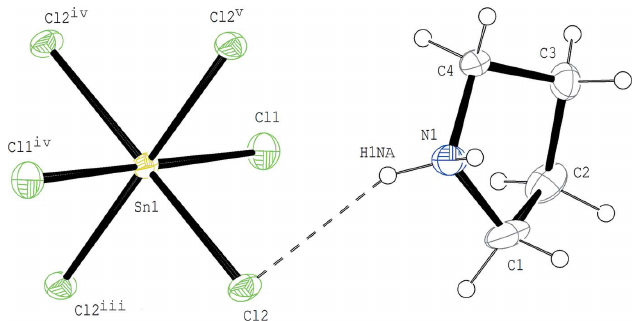
Figure 1 The molecular structure of the title compound, showing the atom- numbering scheme. Displacement ellipsoids are drawn at the 30% probability level. The N—H (cid:2)(cid:2)(cid:2) Cl hydrogen bond is shown as a dashed line (Table 1). Only one component is shown for the disordered cation. [Symmetry codes: (iii) x , (cid:3) y + 1, z ; (iv) (cid:3) x + 1, (cid:3) y + 1, (cid:3) z ; (v) (cid:3) x + 1, y , (cid:3) z